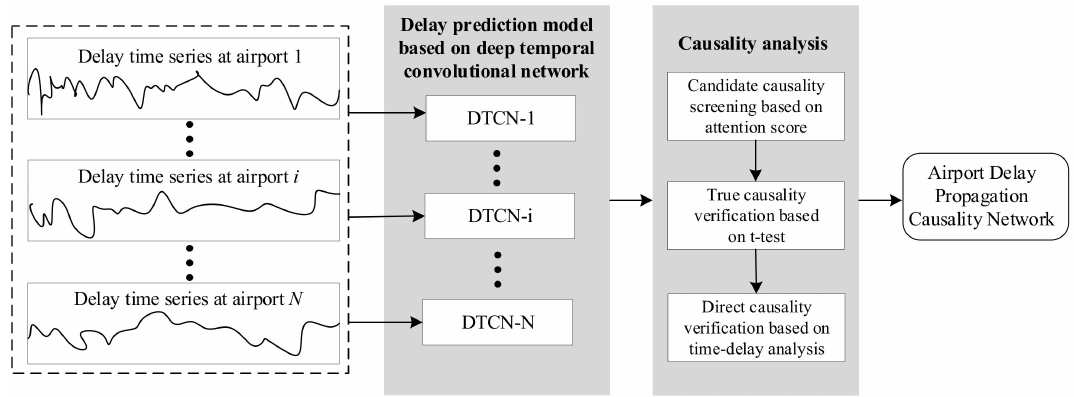
Figure 4. The general idea of causality mining of airport delay